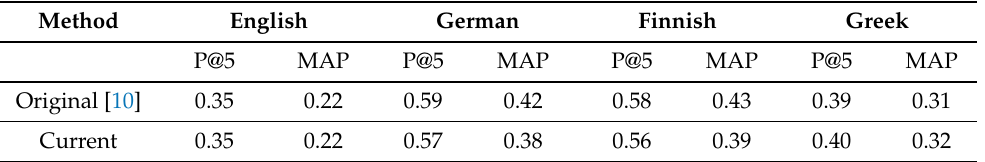
Table 1. Experimental results for four handwritten segmentation-free datasets.